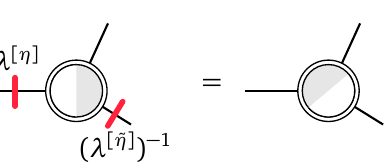
Figure 32: Re-isometrization of a node in the canonical gauge: If we store the Schmidt values λ [ η ] (red) for all links of a network, we can perform a re-isometrization of a node (and consequently of the full network) using only numerically efficient contractions with these “link-weights” (see Sec. 2.2.2) and their inverses. This approach is much faster than the iterative sequence of QR decompositions in Fig. 27. Due to the minimal bond dimension in canonical gauge, the inversion is always possible. Moreover, the Schmidt values can be efficiently